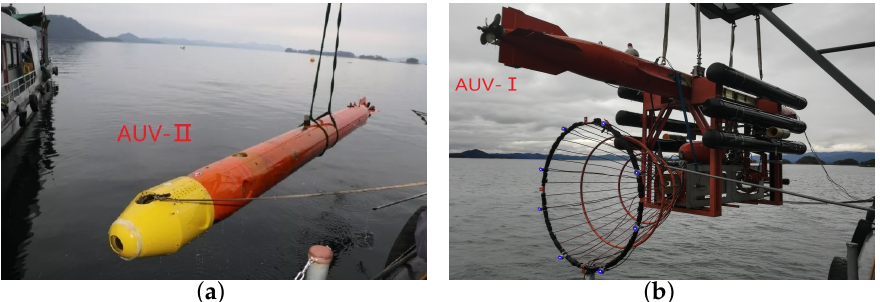
Figure 1. An AUV to be recovered ( a ) and the mobile recovery system ( b